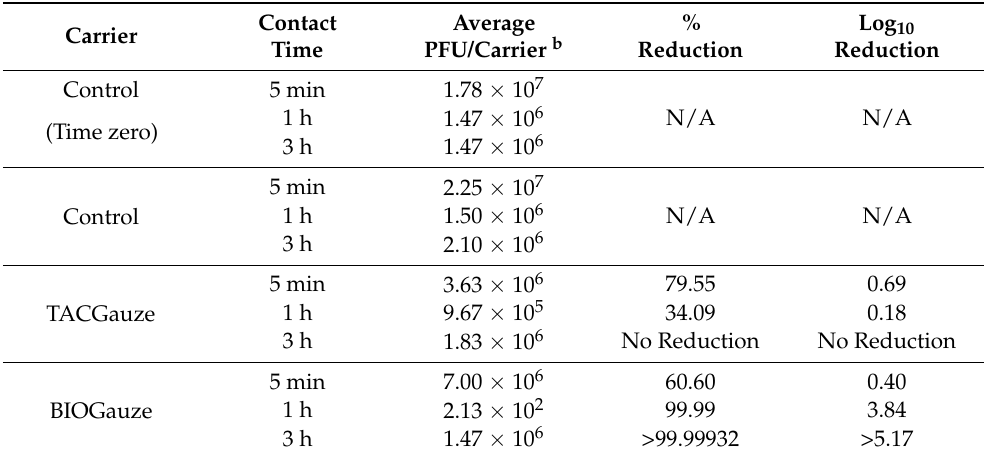
Table 3. Preliminary antiviral screening a result of prototypes tested against surrogate virus, MS2 bacteriophage.